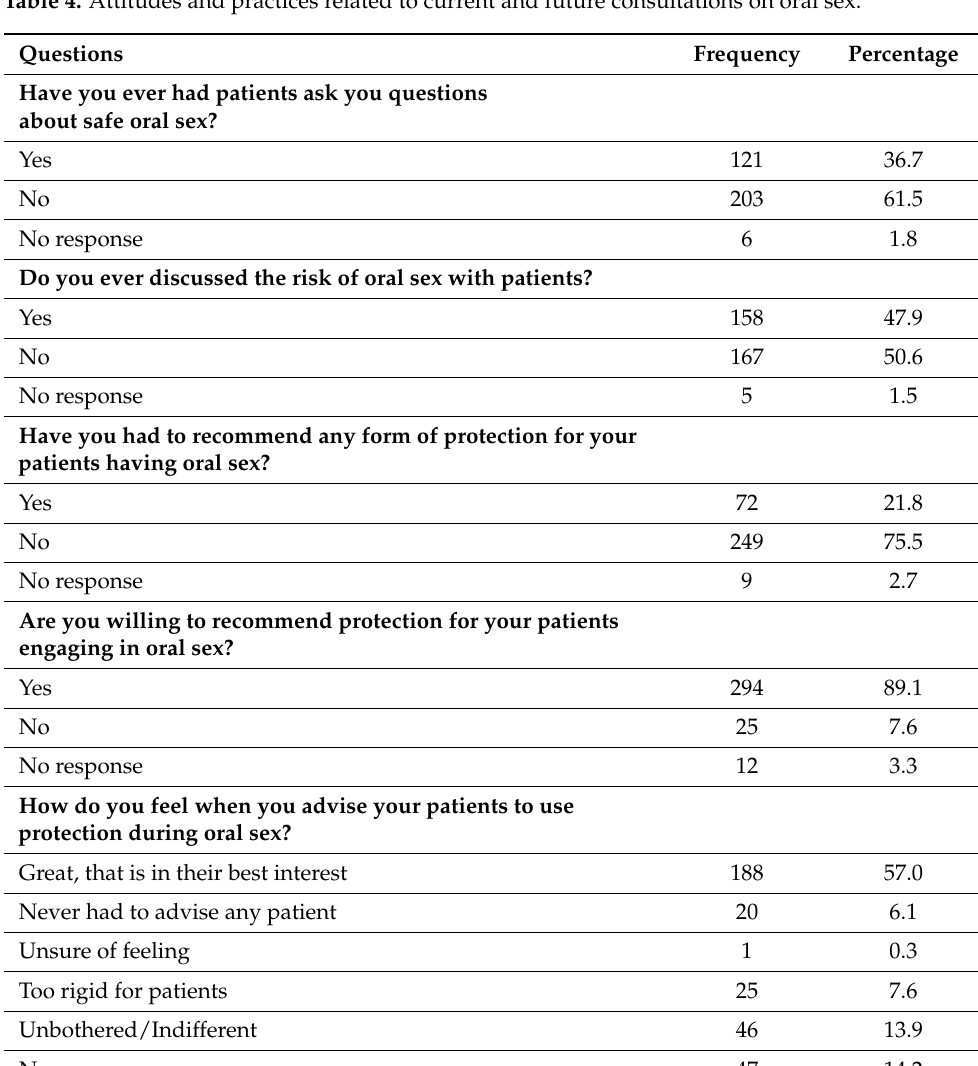
Table 4. Attitudes and practices related to current and future consultations on oral